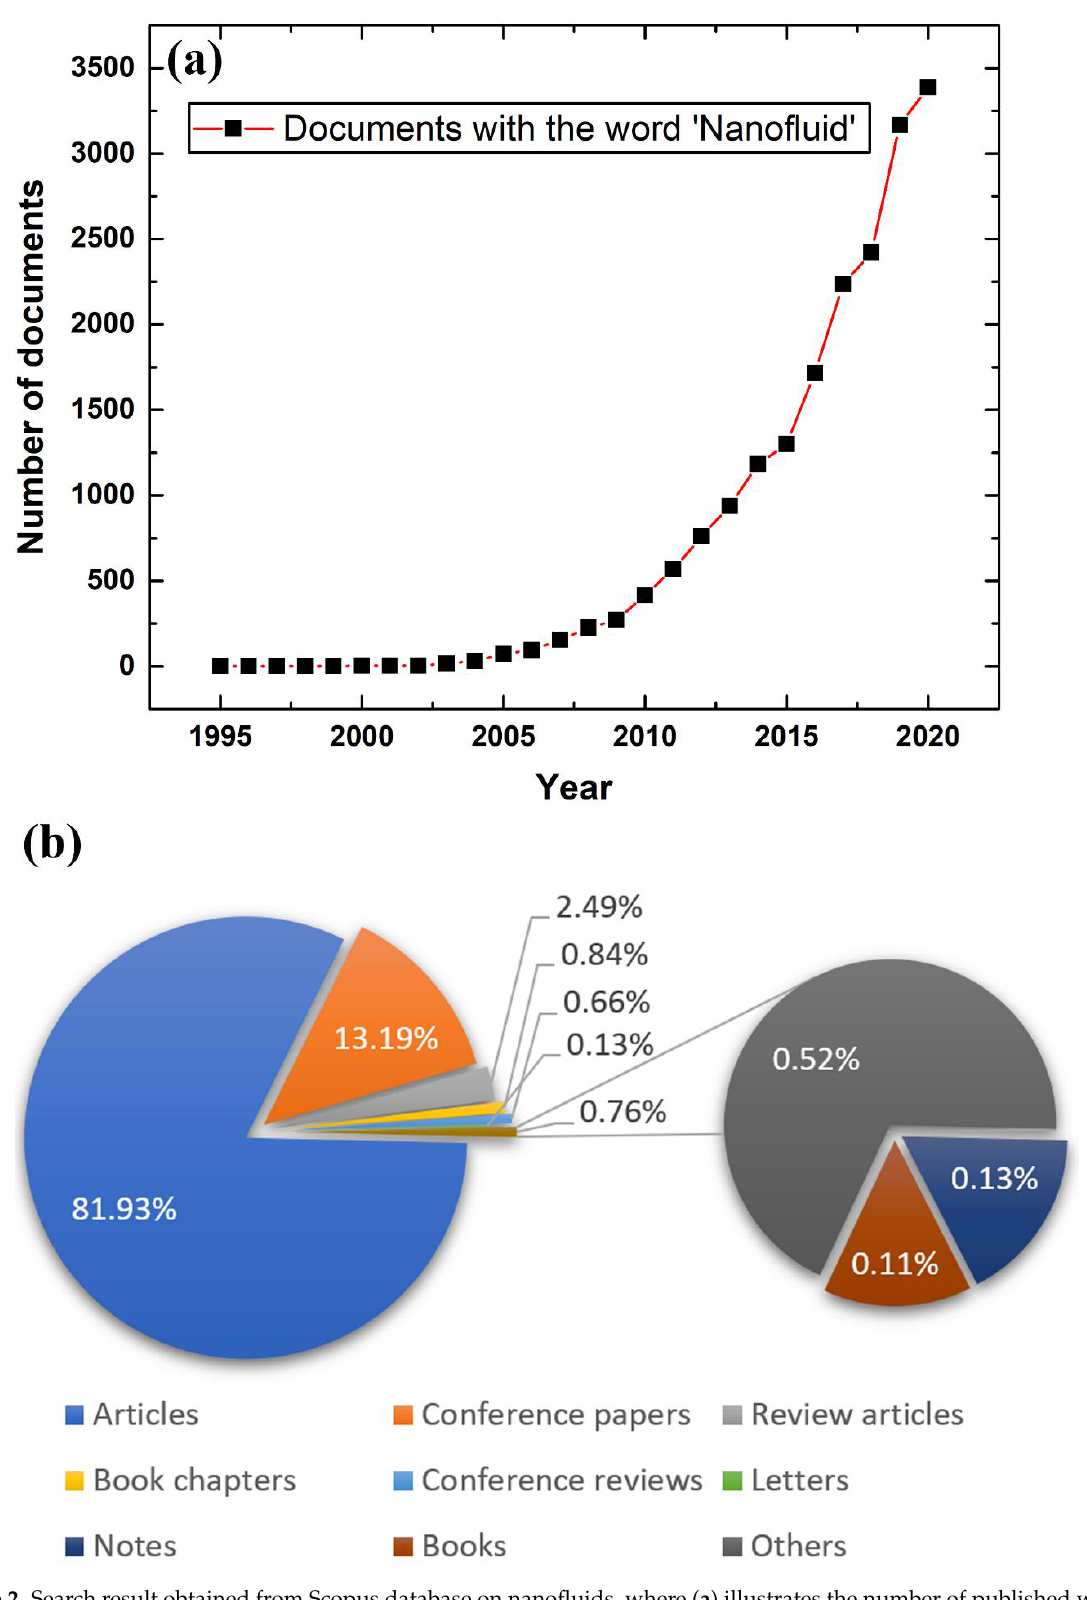
Figure 1. Thermal conductivity of commonly used particles and base fluids for fabricating nanofluids showing an order of magnitude higher in the thermal property for some of the carbon-based materials.